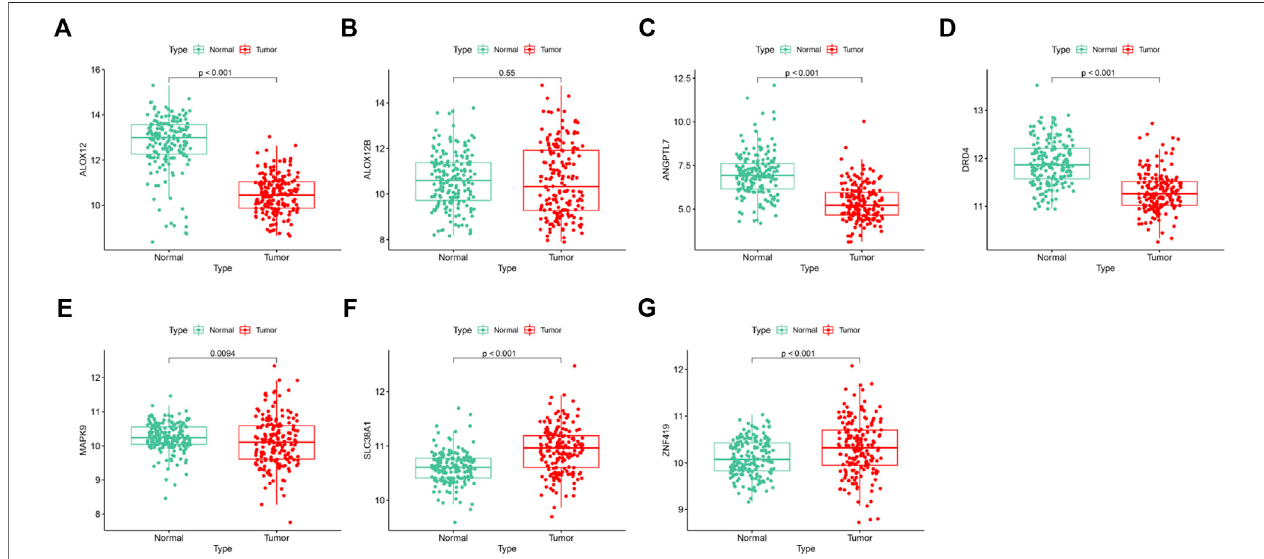
FIGURE 7 | Differentiation analysis of the signature genes among ESCCs and normal tissues based on GSE53625 dataset.